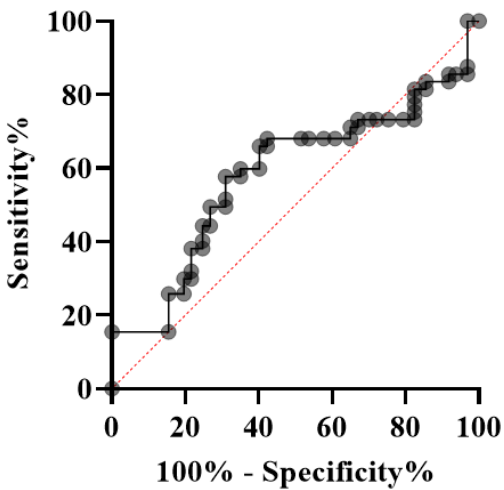
Figure 7. ROC curve of IL17A. Area (CI 95%); p -value = 0.5843 (0.5020–0.6667); 0.0424. The curve illustrates the diagnostic potential of IL17A for this